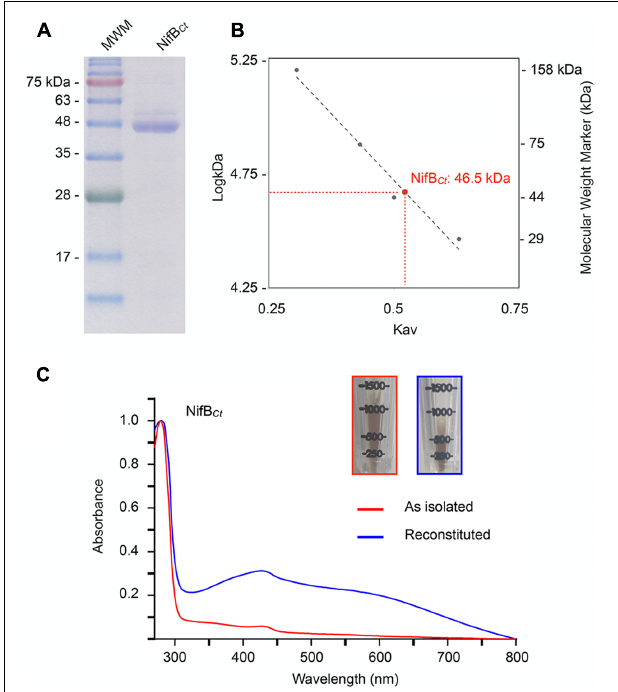
FIGURE 4 | Molecular mass and UV-vis spectra of purified NifB Ct preparations. (A) SDS-PAGE analysis of NifB Ct purified from recombinant A. vinelandii UW422. (B) NifB Ct native molecular weight as determined by size-exclusion chromatography against known protein weight markers. (C) UV-vis spectra of the as isolated (red) and [Fe–S] cluster reconstituted (blue) preparations of pure NifB Ct . The inset pictures show the increase in color intensity upon [Fe–S] cluster